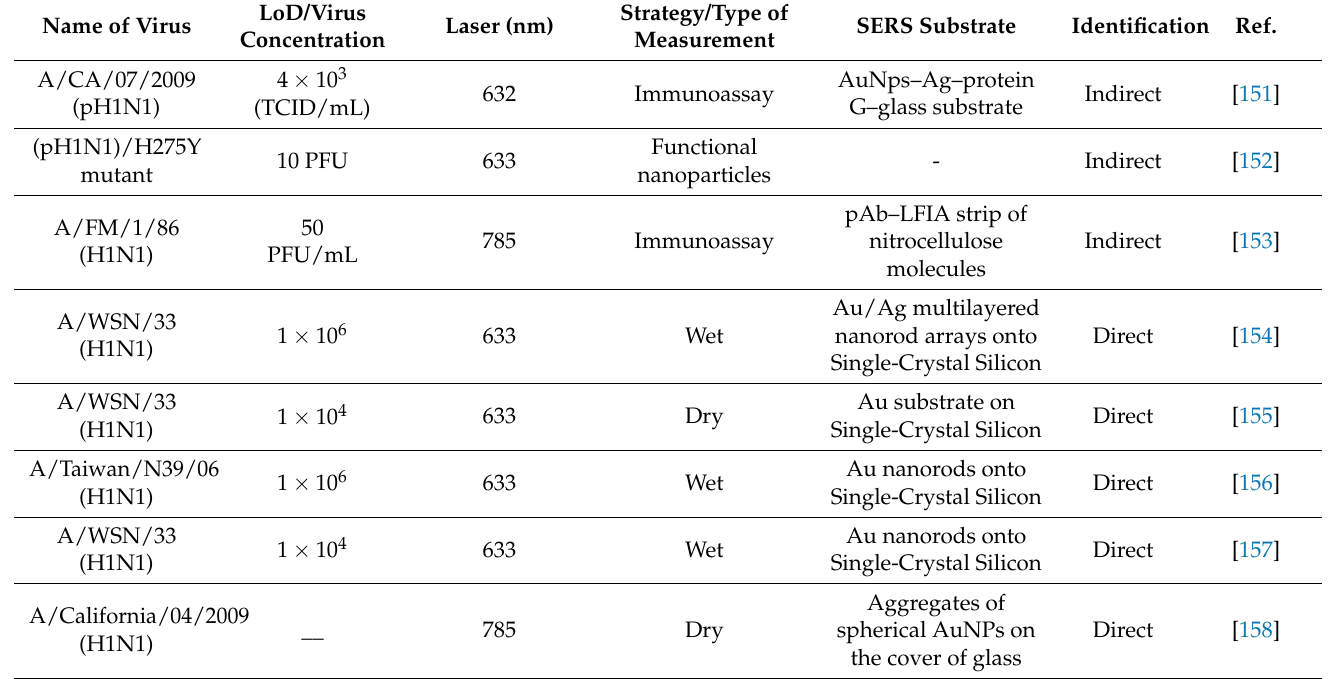
Table 4. Representative studies of the direct and indirect identification of the A(H1N1) influenza virus by surface-enhanced Raman spectroscopy